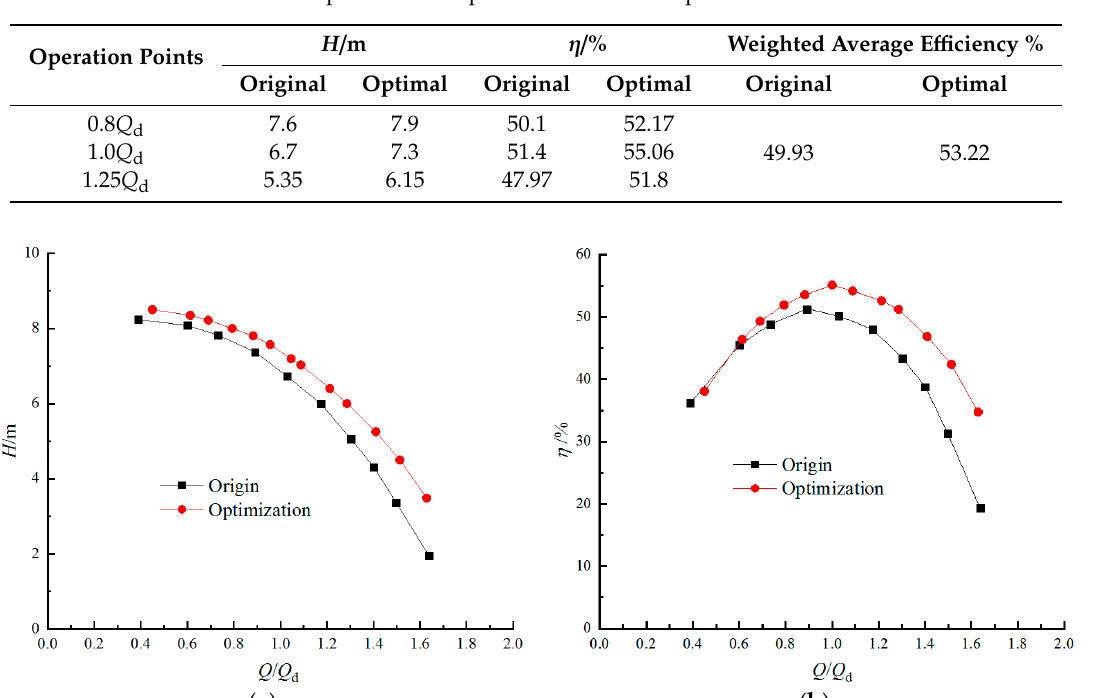
Table 8. Comparison of the performances under specified conditions.